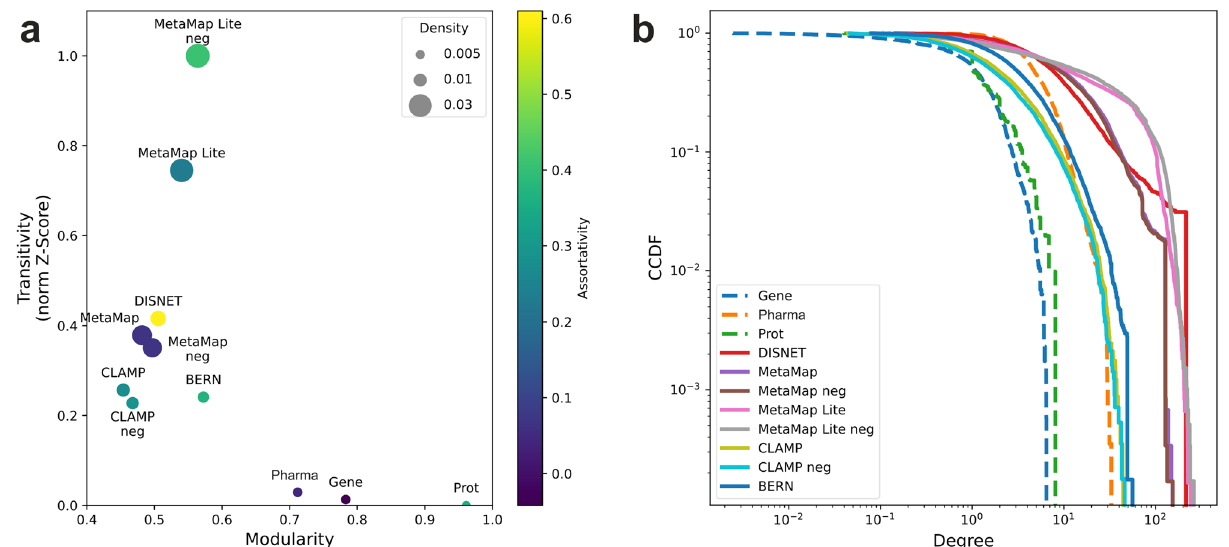
Figure 2. Comparison of network characteristics. ( a ) Location of the analysed networks in the normalized transitivity versus modularity plane. The size and the color of the bubbles represent the density and assortativity of the networks, respectively; ( b ) log–log plot of the degree CCDF of the